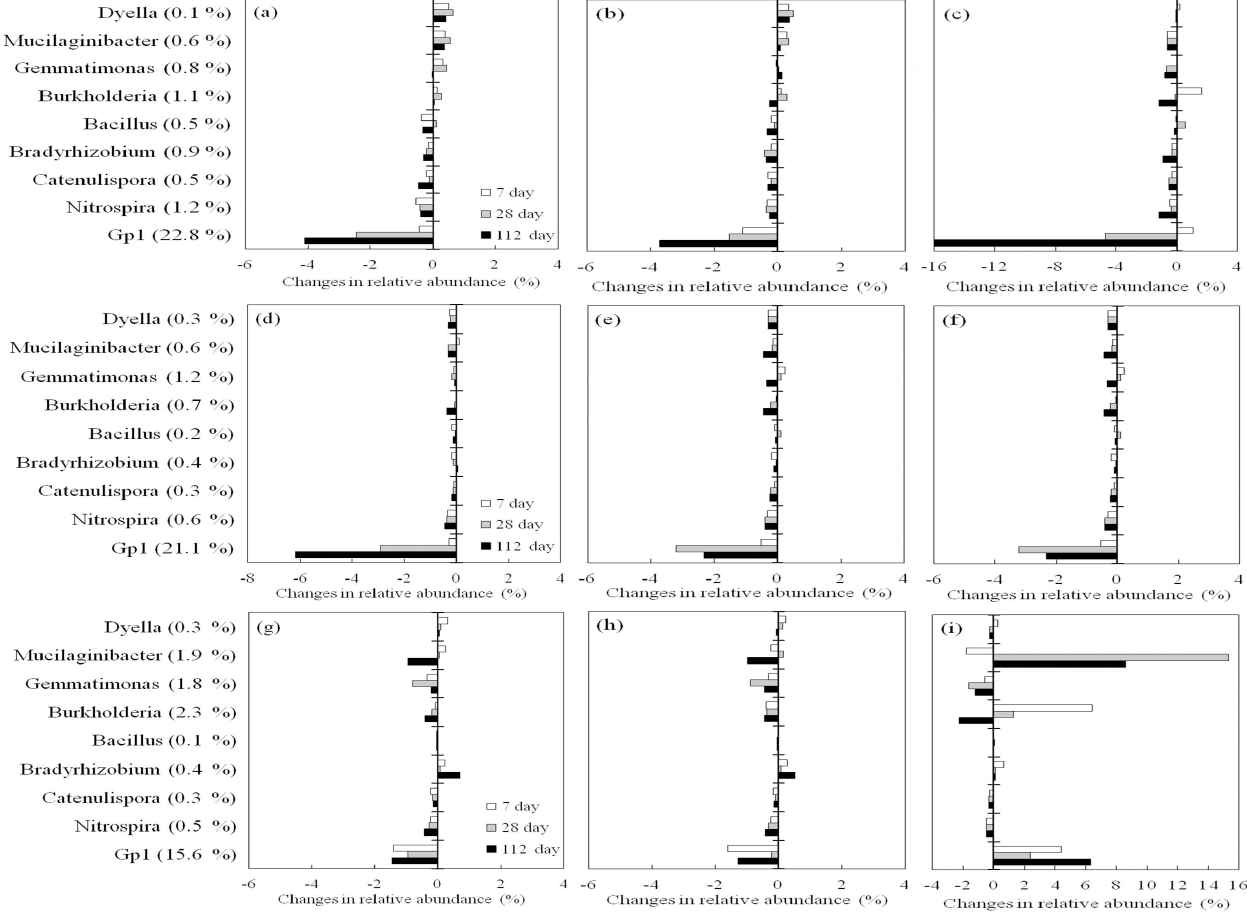
Figure 5. Changes in relative abundance of abundant genera of bamboo soil bacterial communities at (a) 600m, 15 ◦ C; (b) 600m, 20 ◦ C; (c) 600m, 35 ◦ C; (d) 1200m, 15 ◦ C; (e) 1200m, 20 ◦ C; (f) 1200m, 35 ◦ C; (g) 1800m, 15 ◦ C; (h) 1800m, 20 ◦ C; and (i) 1800m, 35 ◦